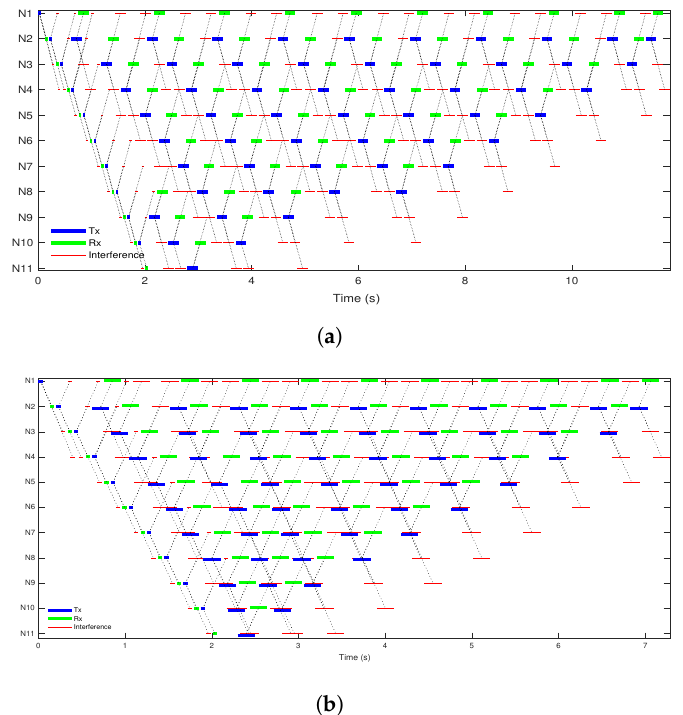
Figure 7. Simulated MAC schedules for the 2 km 10-hop scenario. Tx: Transmission, Rx: Reception.